Question: Condense the content of this figure into a single sentence.
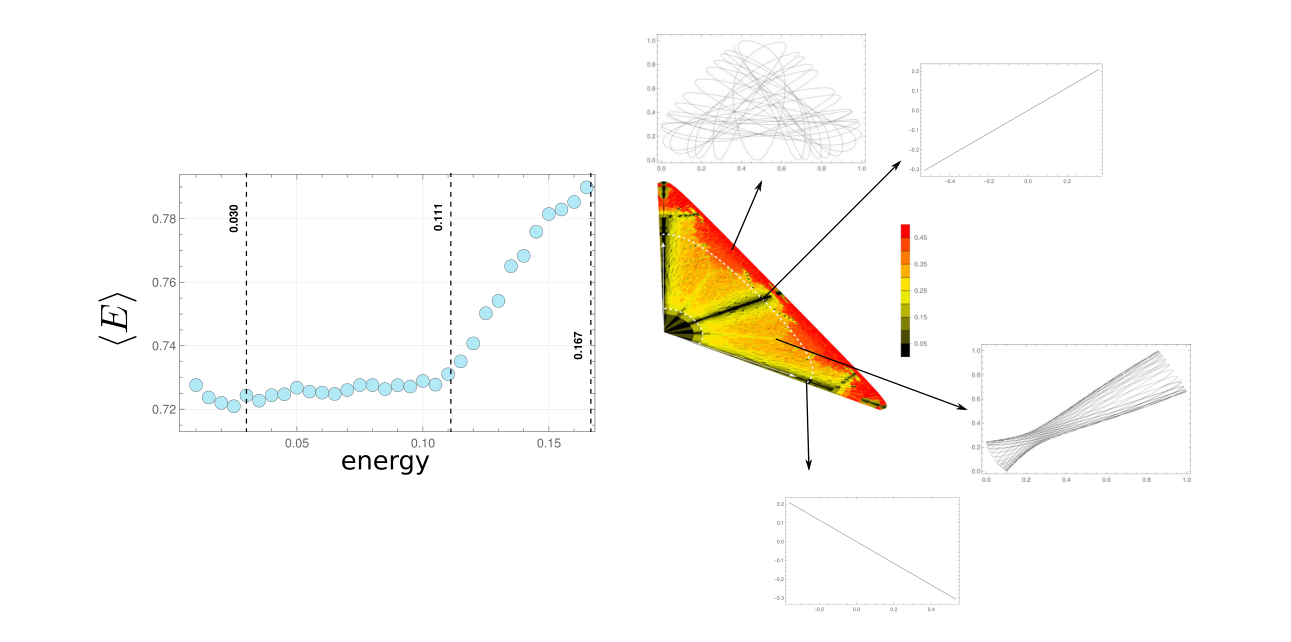
Answer: Regular and irregular orbits in the H´enon-Heiles potential. Left: Eﬀective measure complexity analysis of orbits in the H´enon-Heiles potential. ⟨E⟩is the mean value of the eﬀective measure complexity. At low energies, regular orbits are almost the total of all orbits; after a transient, at roughly 0.030 the eﬀective measure complexity settles in a plateau in the interval [0.030, 0.111] at a mean value of 0.726 ± 0.002 where almost all orbits are still regular. For energy values larger than 0.111, the mean entropy density increases monotonically until an energy of 1/6, which corresponds to the escape energy. This the region where irregular orbits starts to dominate. Right: In the inner energy well, below 1/6 there is a wealth of diﬀerent orbits depending on the initial conditions. Taking initial starting from the rest condition and diﬀerent starting position, the entropy density was calculated from the chain coded trajectories and shown as a color label at each point in the we